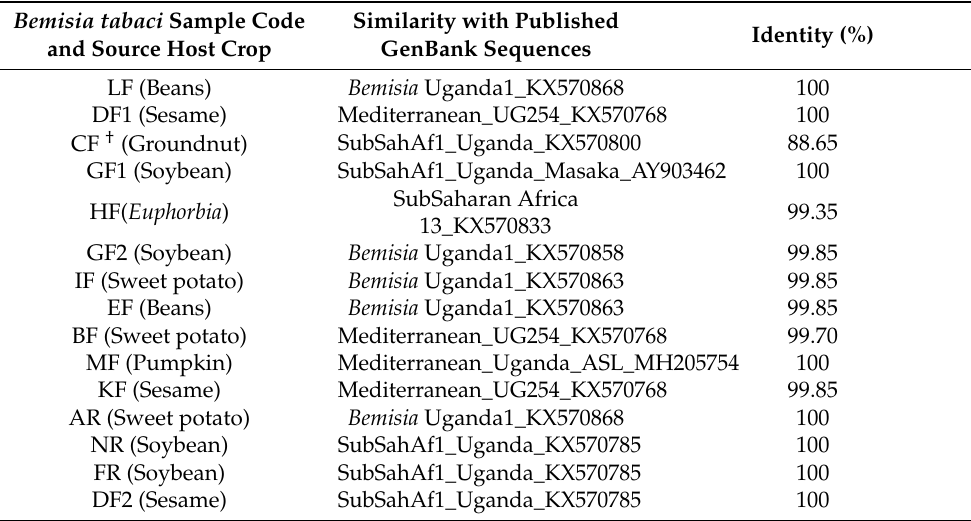
Table 2. Diversity of Bemisia species on other non-cassava crops in the study landscapes. The sample included nymphs